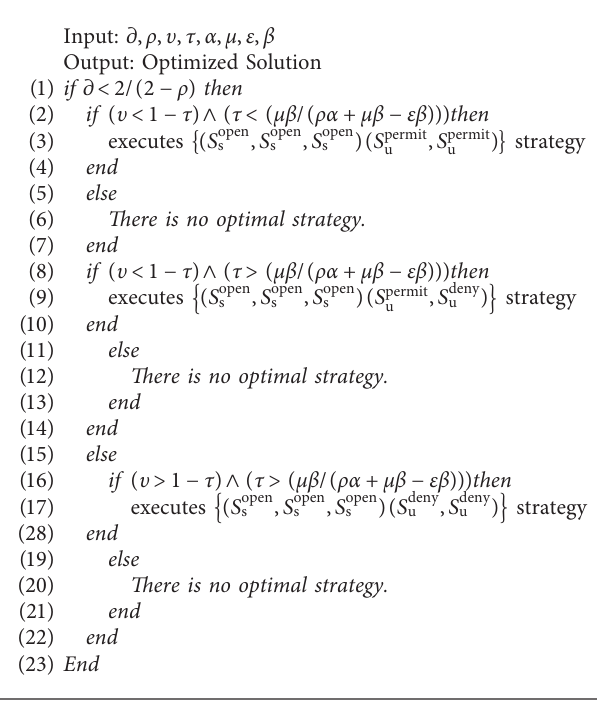
A LGORITHM 1: Solving algorithm for optimal strategy of intrusive mimic relation